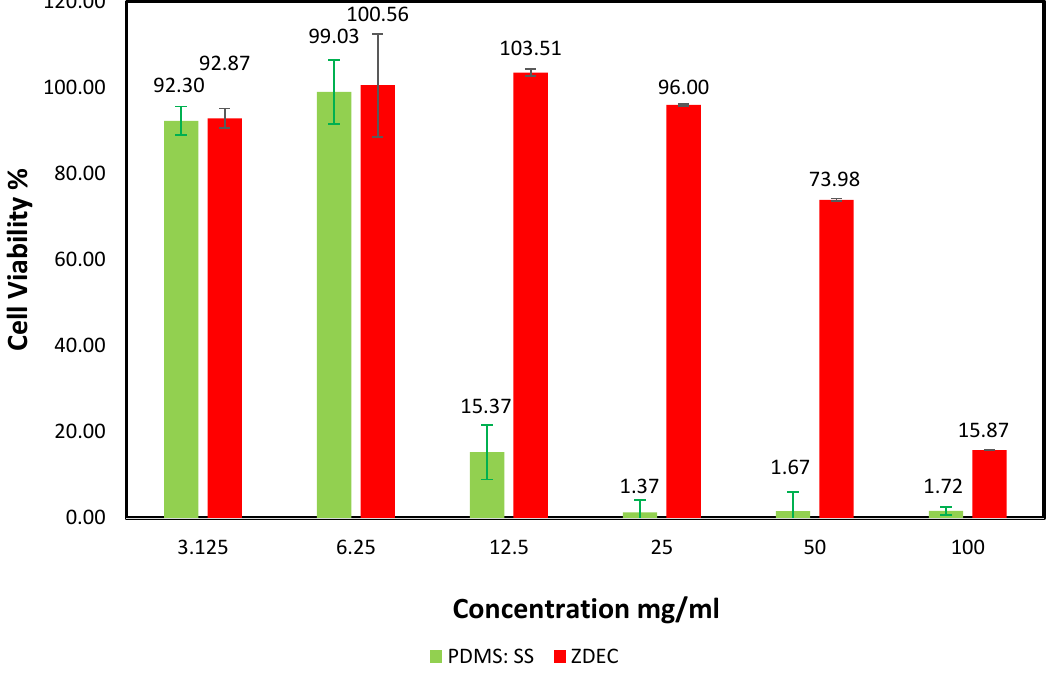
Figure 2. Percentage of L929 cells viability at various concentrations of Zinc diethyldithiocarbamate (ZDEC) and PDMS: SS coating. The experiments were conducted in triplicate independently (n = 3), and the data are expressed as the means ± standard deviation (SD) with p < 0.05.